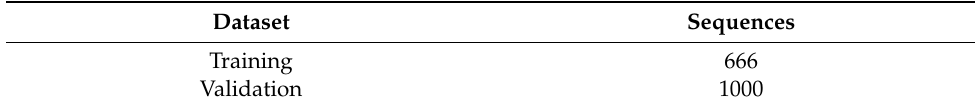
Table 6. Size of the original training and validation